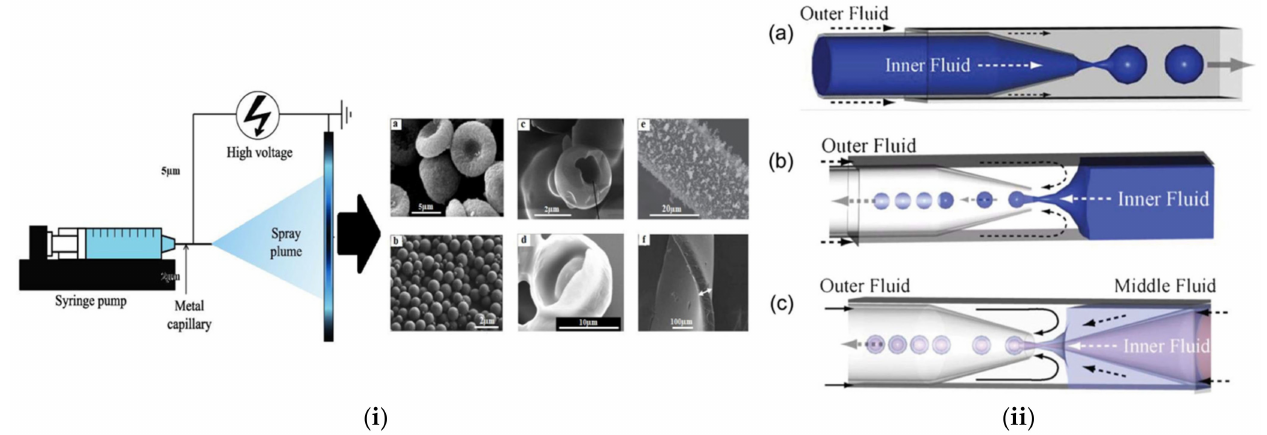
Figure 2. ( i ) Different structures prepared by the electrospraying method: ( a ) hollow sphere, ( b ) spherical particle with smooth surface, ( c ) hollow particles, ( d ) electrospray droplets ( f ) electrically conducting substrates and ( e ) enteric coated particles. ( ii ) Schematic demonstration of microfluidic devices for fabricating monodisperse microparticles: ( a ) co-flow capillary device, ( b ) flow-focusing capillary device, and ( c ) a double emulsion capillary microfluidic device that combines co-flow and flow focusing. Adapted with permission from ref. [22,23]. 2021,